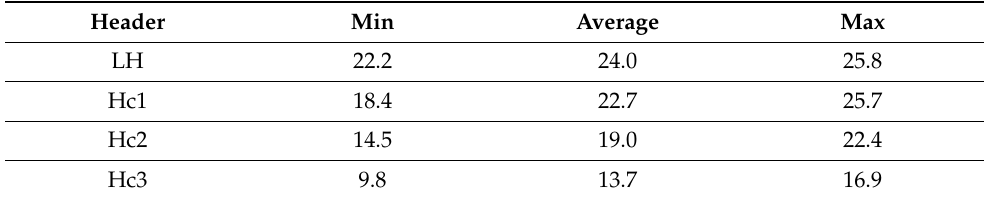
Table 1. Water temperature ( ◦ C) measured in Lake H é v í z (LH) and H é v í z canal (sample sites